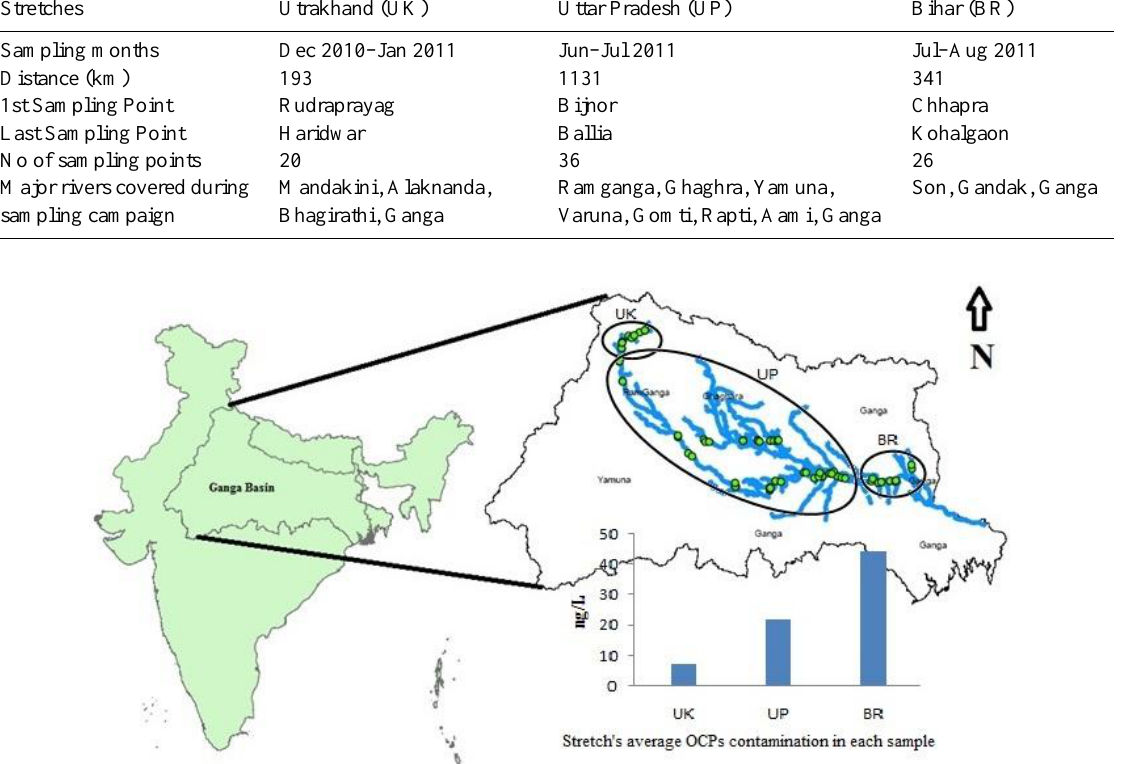
Figure 1. Sampling location of the river